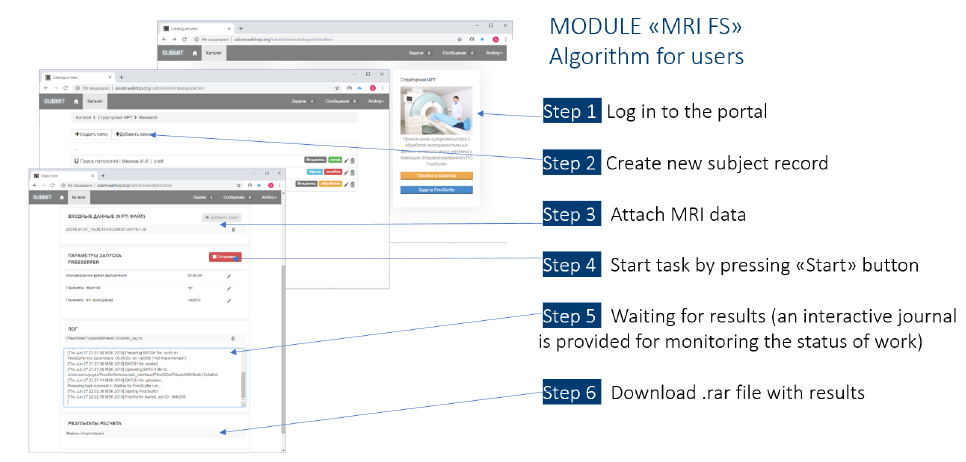
Figure 3. (Color online) Module “MRI FS”. Algorithm for